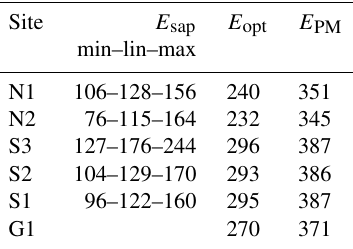
Table 1. Seasonal totals in mm of estimated stand transpiration E sap and potential evaporation E opt and E PM . For the totals we used the period 12 May 2013–31 October 2013. For E sap we present a range of estimates with minimal, linear decline and maximal estimate with respect to the depth of conducting inner sapwood (Eqn. A3, A4, and A5). Site